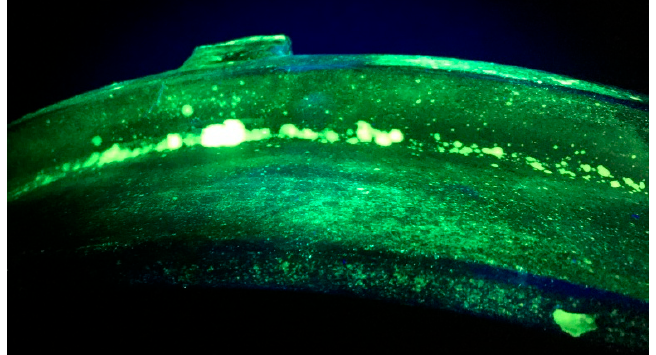
Figure 8. Photo of fluorescence detection of an overheated area in casting runner root before polishing and picking. The brighter areas were marked as defects by fluorescence detection.